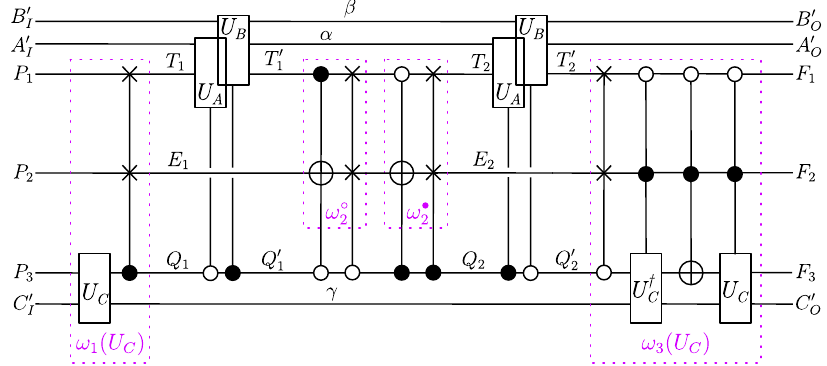
(cid:5)(cid:5) . Notethatforthis (cid:2) T (cid:2) T (cid:2) T 0 1 ! T 1 , 1 T 0 1 ! 2 ! T 2 , 1 , 1